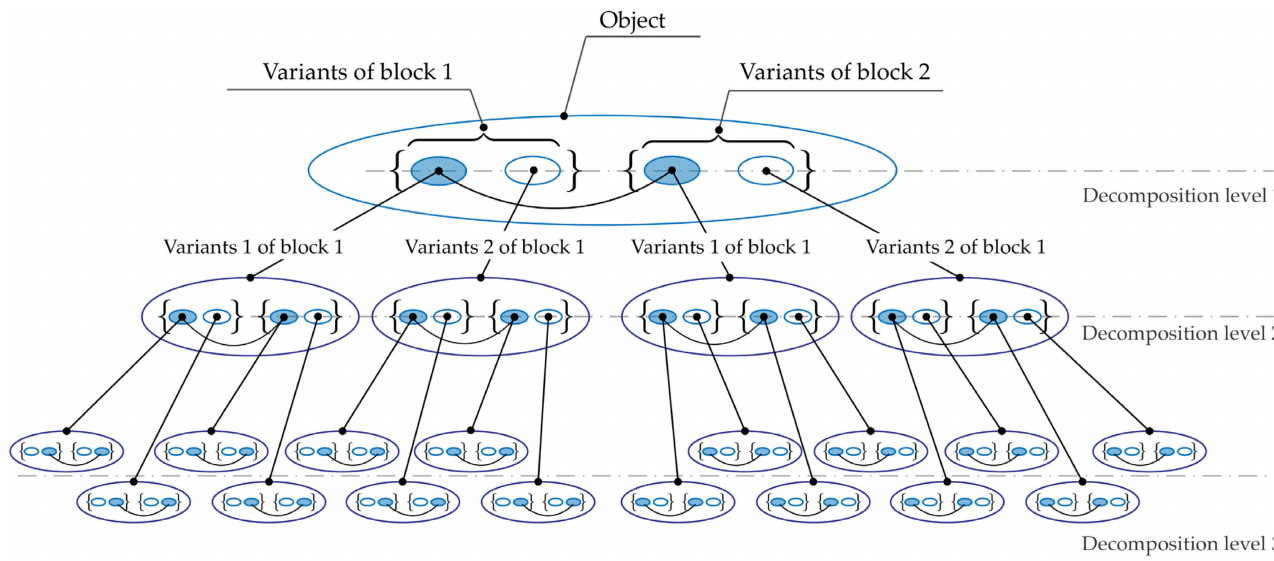
Figure 4. Decomposition of the article into component blocks. The dark color indicates blocks with a minimum upper boundary for the minimum cost of